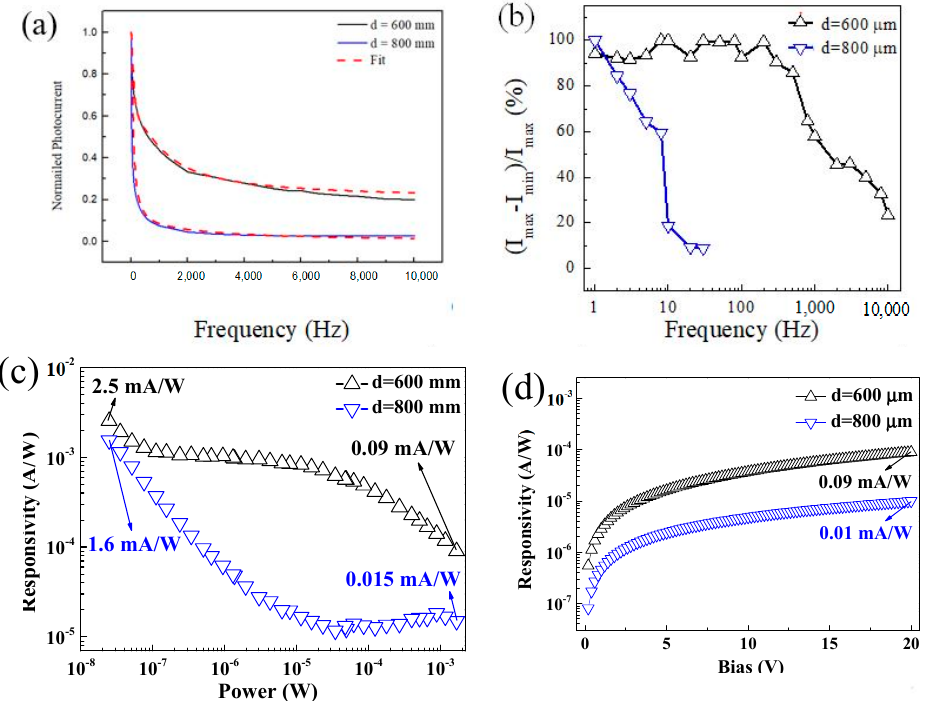
Figure 3. (Color online) ( a ) Frequency response of photoconductivity and time constant fitting of SnS 2 film with different finger spacing; ( b ) the relative balance [(I max − I min )/Imax] versus frequency of SnS 2 film with different finger spacing. ( c ) Laser power and ( d ) bias voltage-dependent photoresponsivity of SnS 2 film with different finger spacing. Table 1. Fitting results of τ 1 , τ 2 , k 1 and k 2 for SnS 2 film with 600 and 800 μ m electrode spacing.